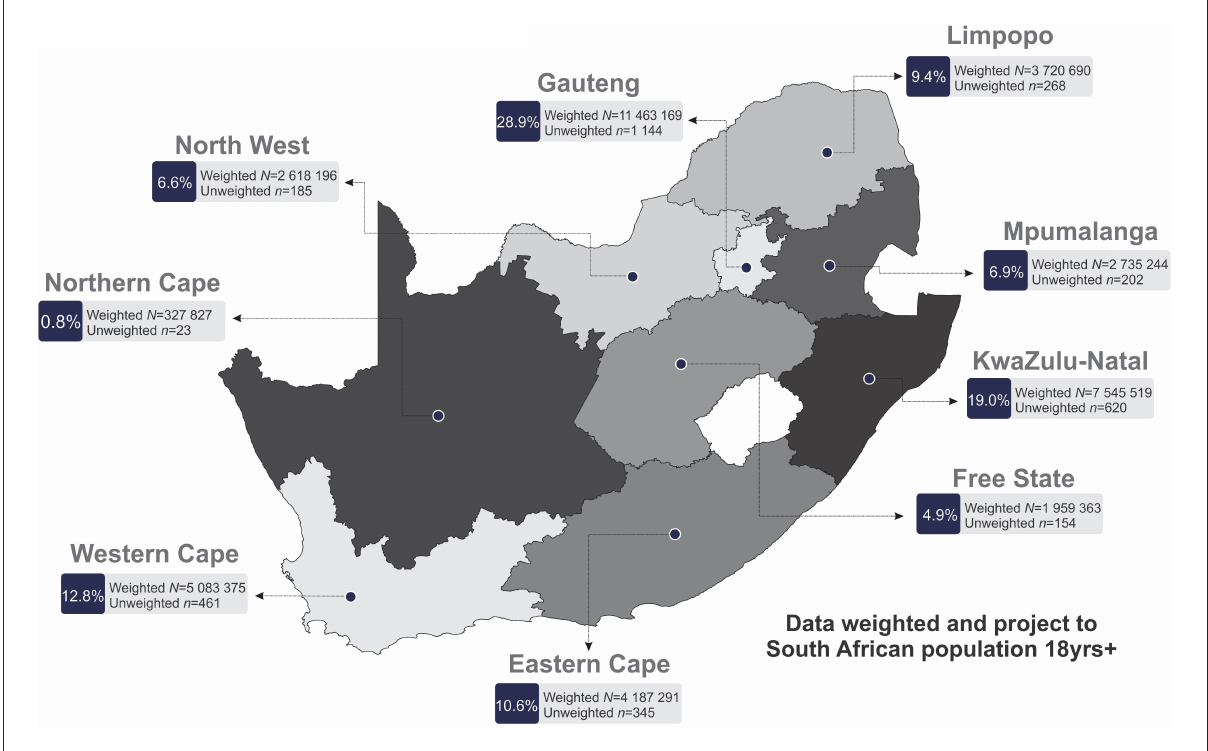
FIGURE1 Population demographics outlining the nine provinces of South Africa.